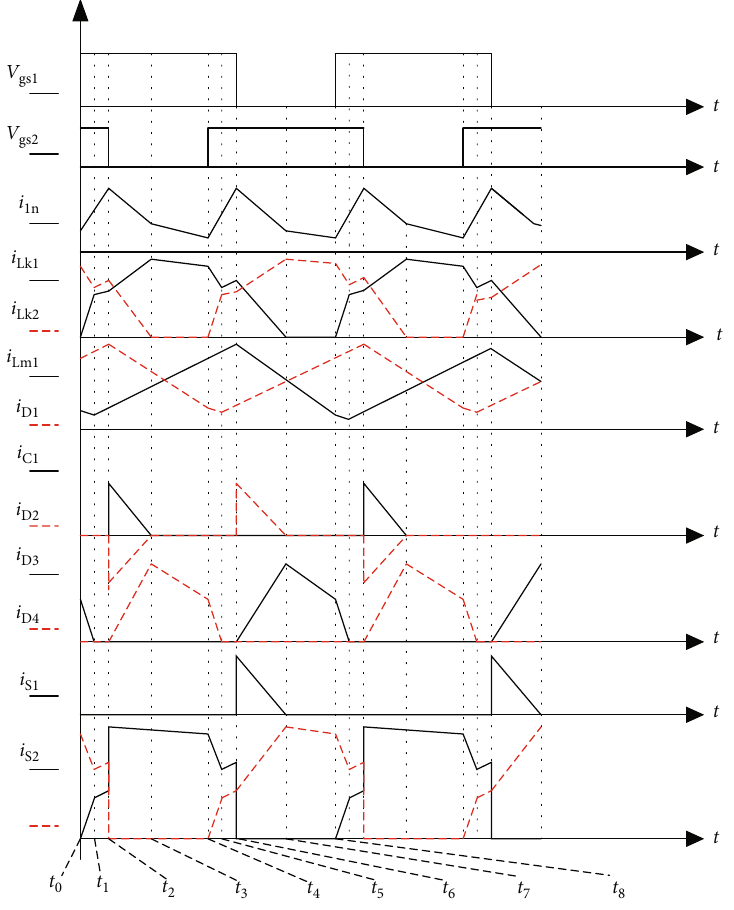
Figure 3: Key waveforms of the proposed